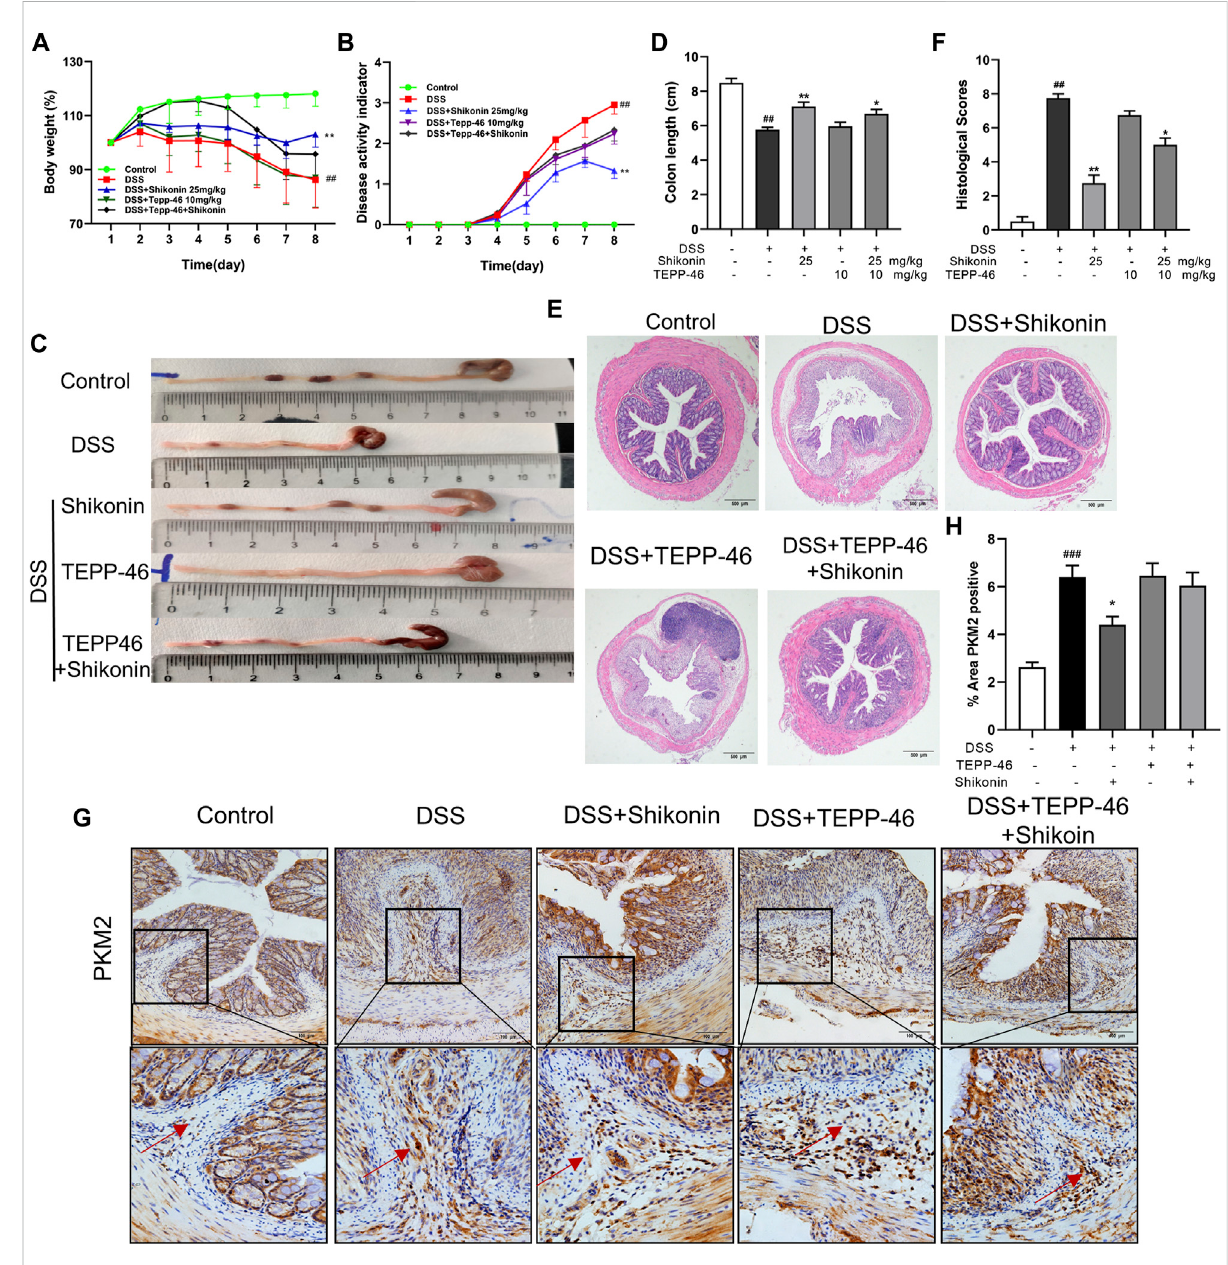
FIGURE 8 Shikonin enhanced the anti-UC effect of TEPP-46 in colitis mice. The body weight (A) and DAI (B) of mice during the course of colitis. Representative images (C) andstatistics (D) of colonlength ineach group. Representative images (E) ofH&E-stainedcolon tissue samples (scalebar, 500 μ m)andhistologicalscores (F) ofcolonictissues.ExpressionofPKM2incolonofcolitismiceweredetectedbyimmunohistochemistryassay (G) withthestatistics (H) .Dataareshownasthemean±SD, n =5 – 8.## p < 0.01,comparedtothecontrolgroup.* p < 0.05,** p < 0.01,comparedto the DSS